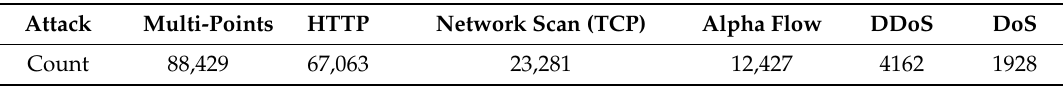
Table 8. Number of attacks in anomalous traffic. DoS = denial of service; DDoS = distributed denial of service.